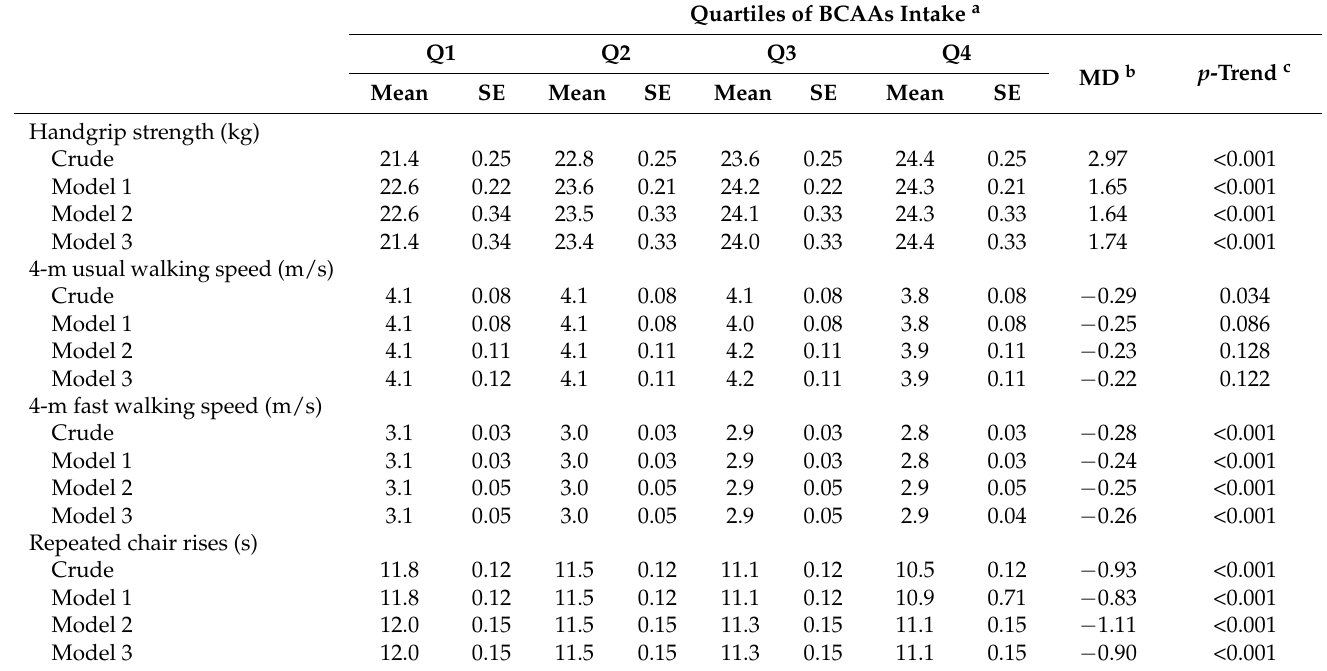
Table 3. Covariate-adjusted mean changes in four physical performance indicators by quartiles of total BCAAs intakes ( n =